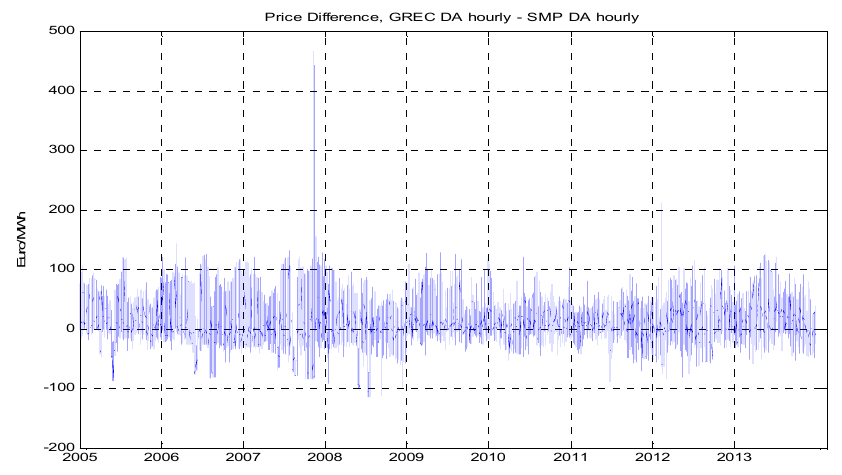
Figure 3. The price difference GREC DA-SMP DA, hourly data,